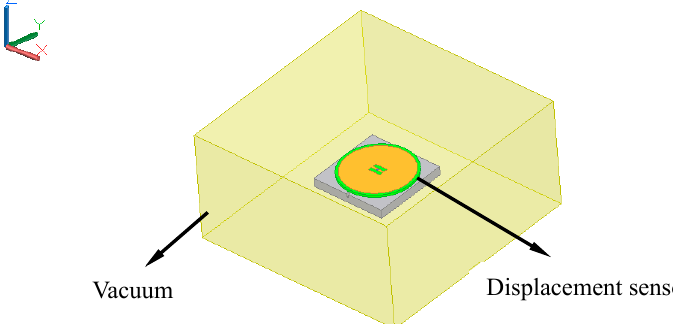
Figure 5. Displacement sensor model using Ansoft high frequency structure simulator (HFSS).